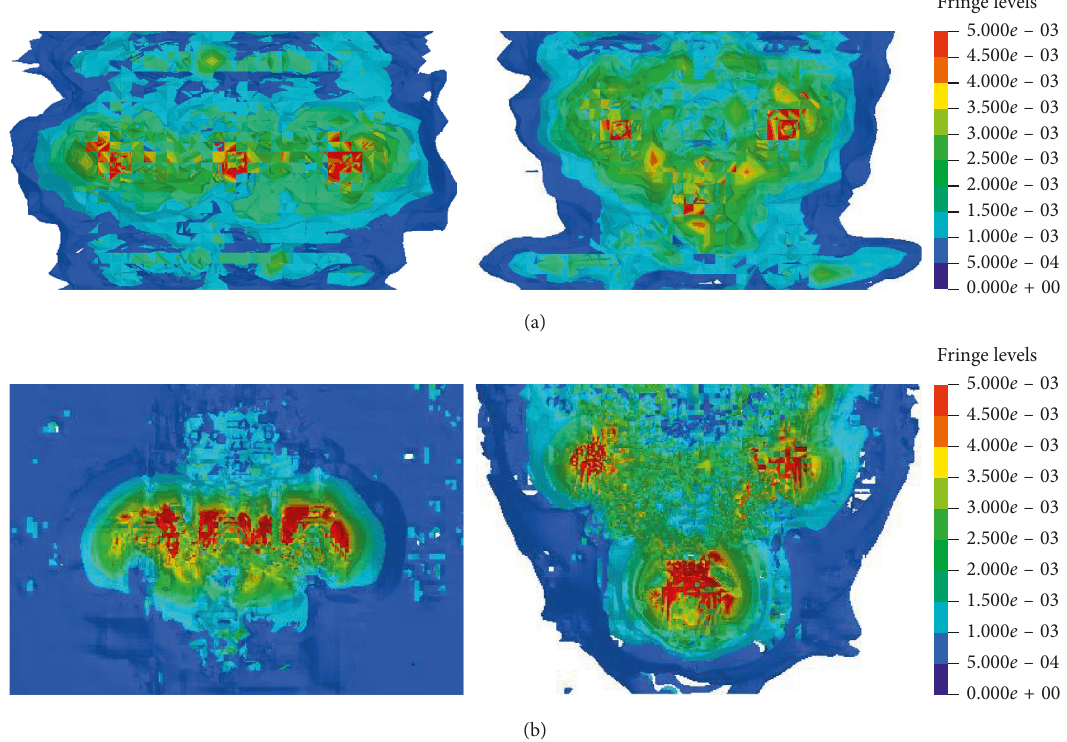
Figure 17: Comparison of max principal strain. (a) Comparison of “straight-line” blasting layout and “triangle-fractal” blasting layout. (b) Comparison of “straight-line” blasting layout and “deep-shallow-fractal” blasting